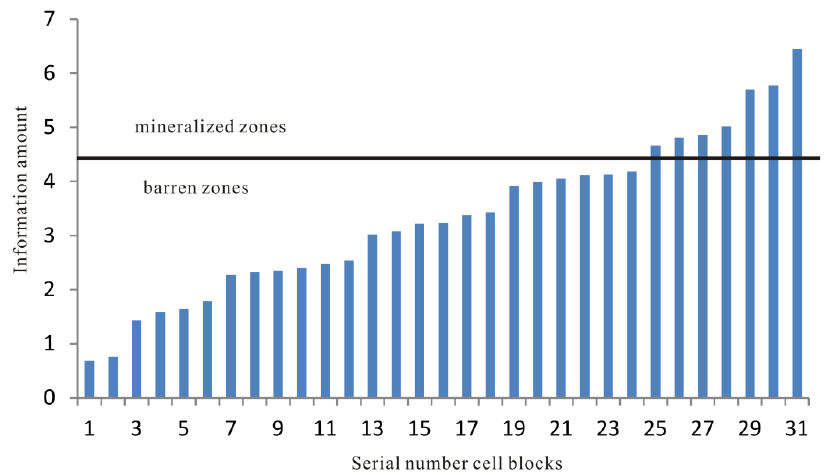
Figure 6. Advantageous metallogenic target ( a ) and predicted target areas ( b ) of deep metallogenic in the Jiaojia fault.